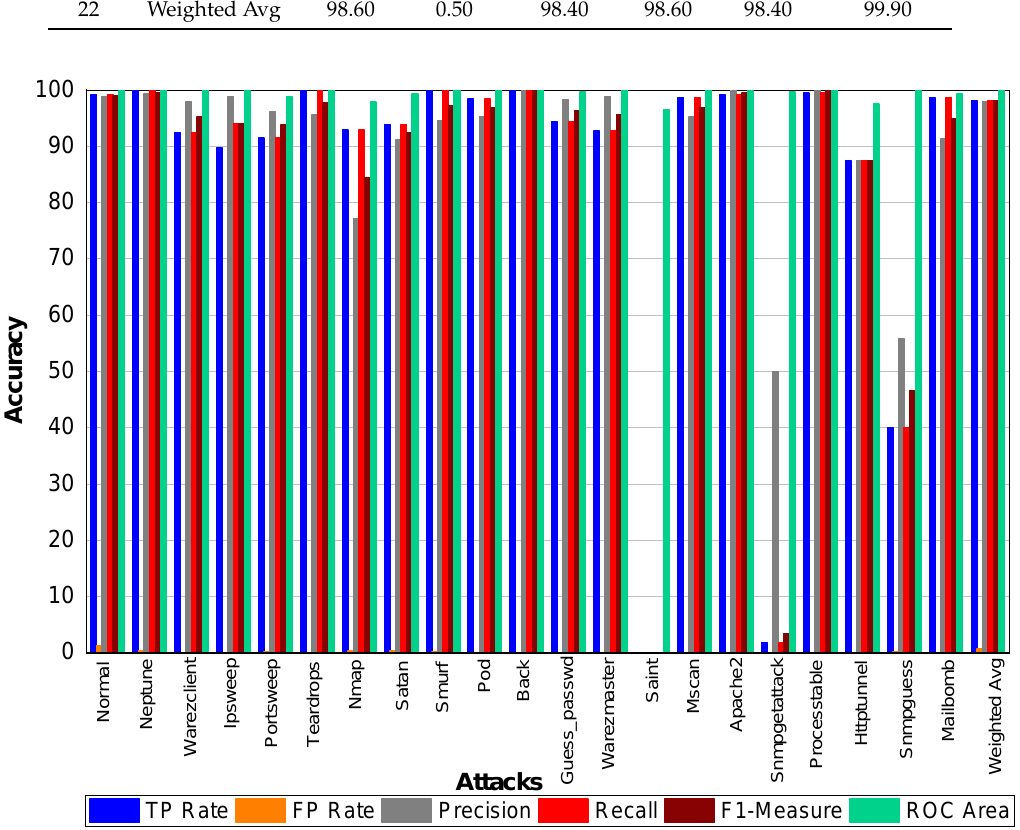
Figure 13. Classification report for the Bagging Random Forest NSLKDD